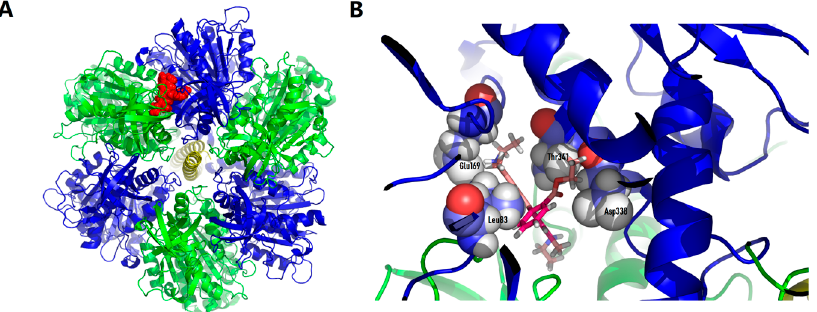
Figure 8. Rhodamine 6G docked structures on human ATP synthase. ( A ), whole ATPase complex overview (green, α -subunits of ATP synthase; blue, β -subunits of ATP synthase; red, rhodamine 6G). ( B ), binding pocket close up look with amino acid residues (L83, E169, D338, T341) involved in binding to rhodamine molecule. While searching for the binding site during docking from several locations, the equally optimal location for the ligand was found. The estimated binding energy was estimated by the Autodock vina program at 8.3 kcal/mol.